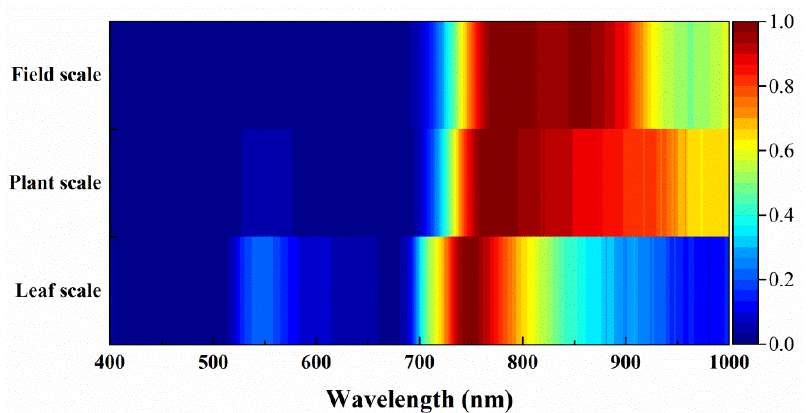
Figure 7. The dispersion of each wavelength at multiple scales.